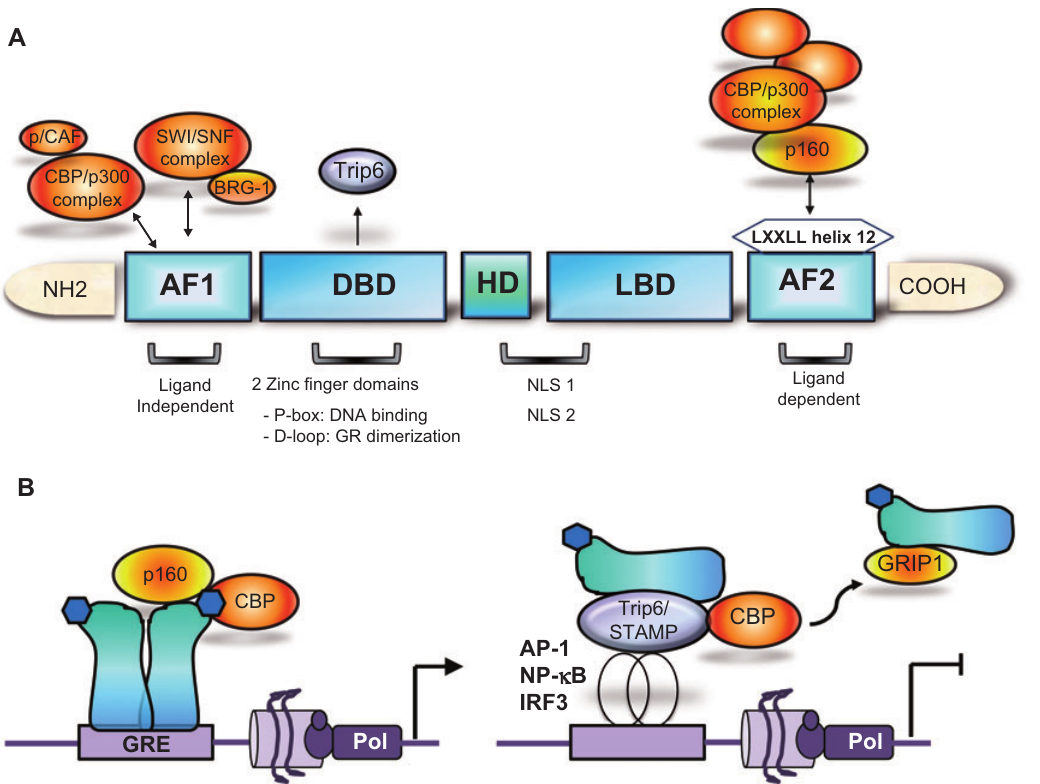
Figure 1 Primary structure of the glucocorticoid receptor (GR). (A) The transactivation domain AF-1 is followed by the DNA-binding domain (DBD) with two zinc fi ngers involved in DNA binding (P-box) and dimerization of the receptor (D-loop), a hinge domain (HD) with two nuclear localization sequences (NLS), a ligand-binding domain (LBD), and a C-terminal transactivation domain AF-2. Coactivators with histone acetyltransferase activity such as CBP/p300, ATP-dependent chromatin remodeling complexes like switch/sucrose non-fermenting (SWI/SNF) proteins enhance the transcriptional activator function of the receptor in a ligand-independent manner. The AF-2 domain has a ligand-dependent coactivator function that recruits coactivators with the LXXLL motif in helix 12. Those coactivators belong to the p160 family, which further recruit multiple coactivators among the CBP/p300. Integrators such as TRIP6 interact with the DBD to mediate transrepression of AP-1. (B) The GR